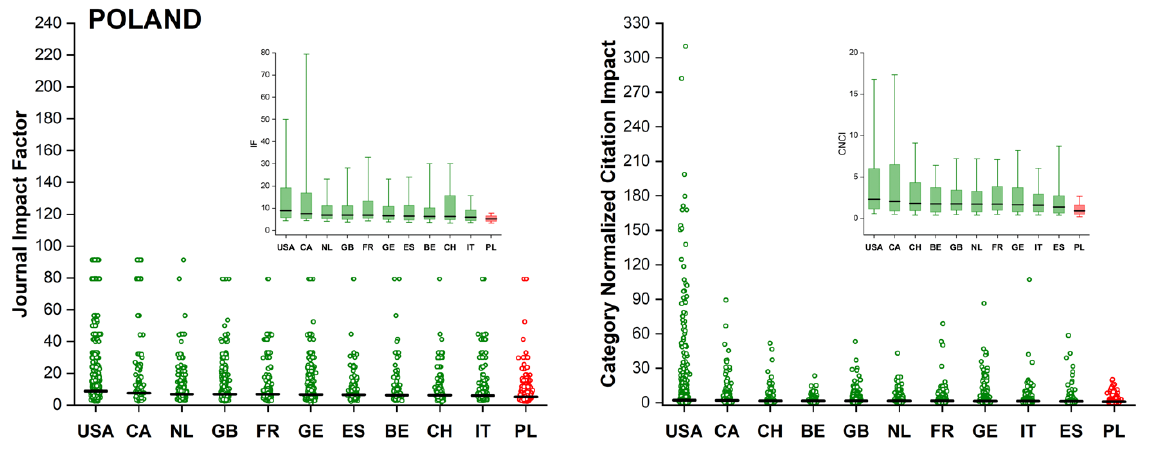
Figure 5. Scientific impact (JIF and CNCI) as a function of the country of affiliation of corresponding authors in Hungary. Red open circles: Hungary; green open circle: countries with an observed sig- nificant difference; open grey circles: no significant difference between the V4 and compared coun- try. Abbreviations: AT = Austria, CA = Canada, CH = Switzerland, ES = Spain, GB = England, FR =